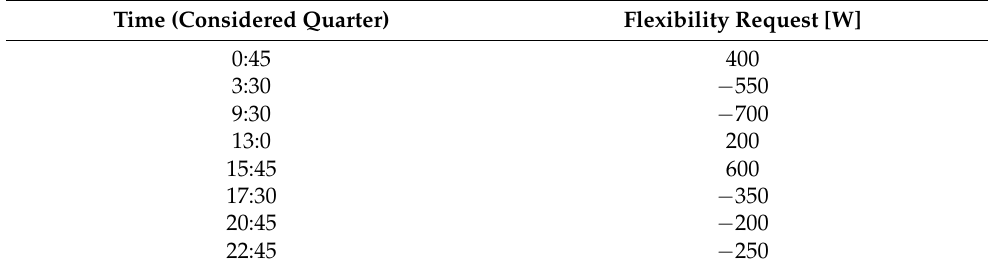
Table 3. Flexibility services requested to the